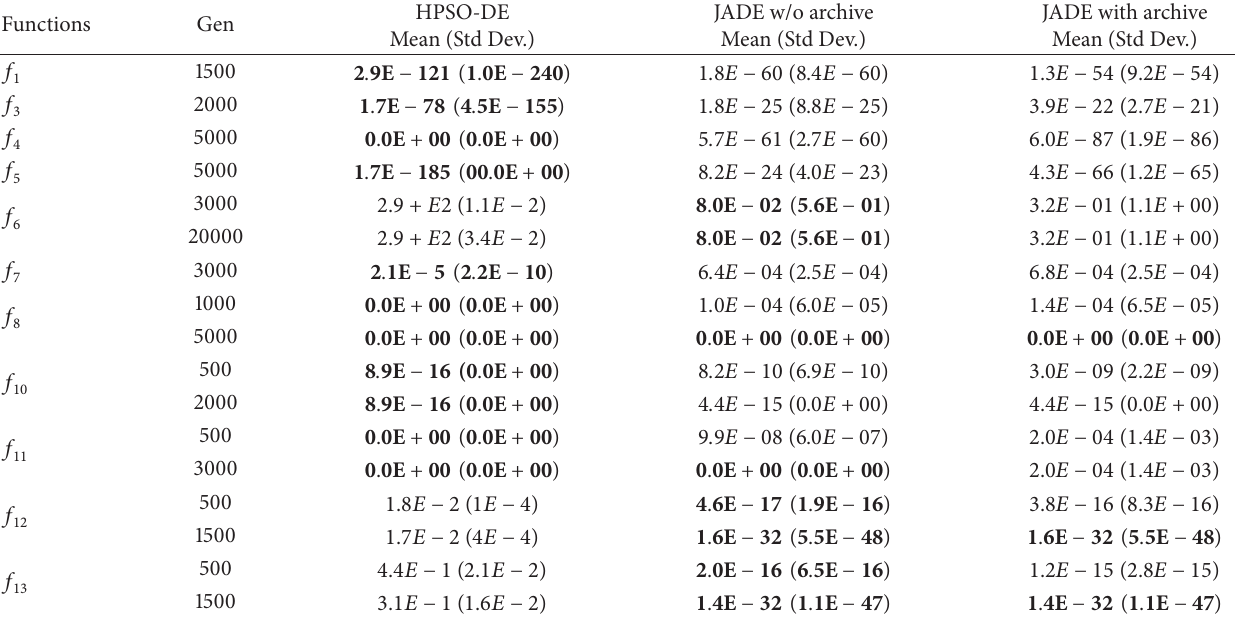
Table 5: Results of the comparison between HPSO-DE and